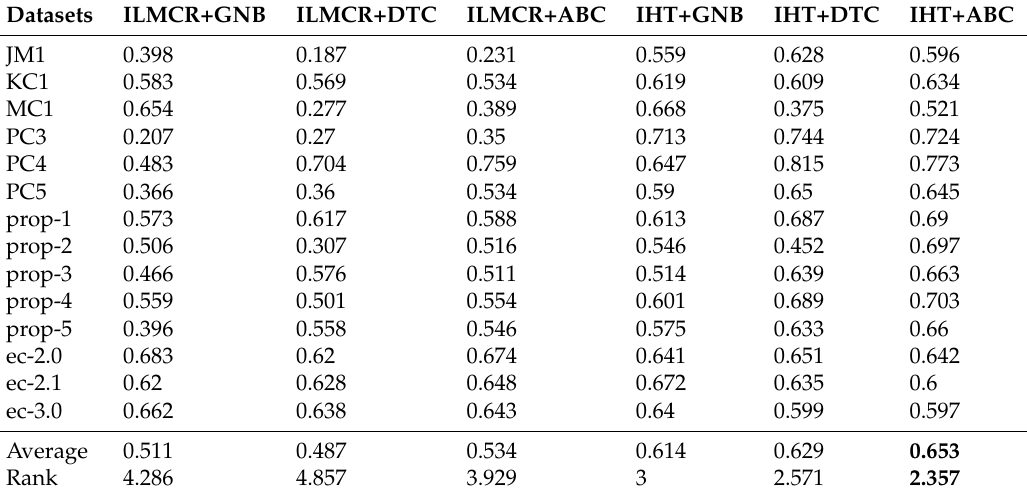
Table 18. G-mean of matching of classifiers with LIMCR and IHT on large